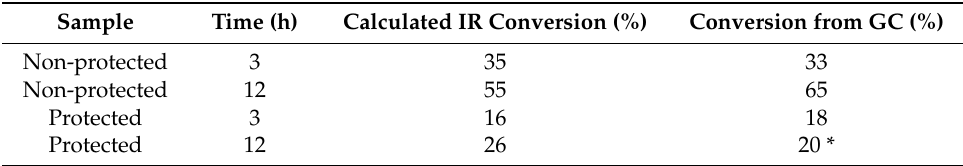
Table 3. Determined BP conversion from GC analysis compared to BP conversion calculated from IR spectral C=N/C=O absorbance